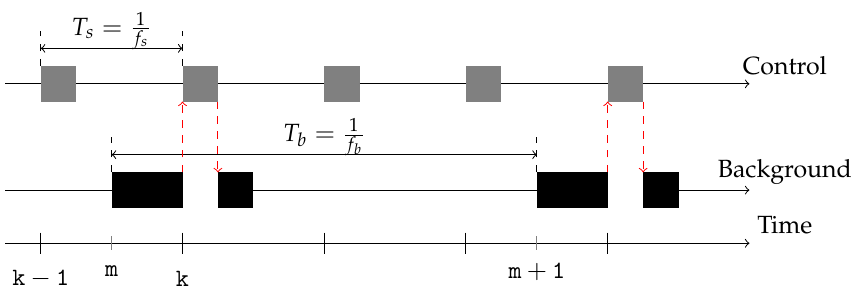
Figure 3. Time diagram showing the parallel run of the two EKF algorithm procedures. T s —control period time, T b —background procedure period.